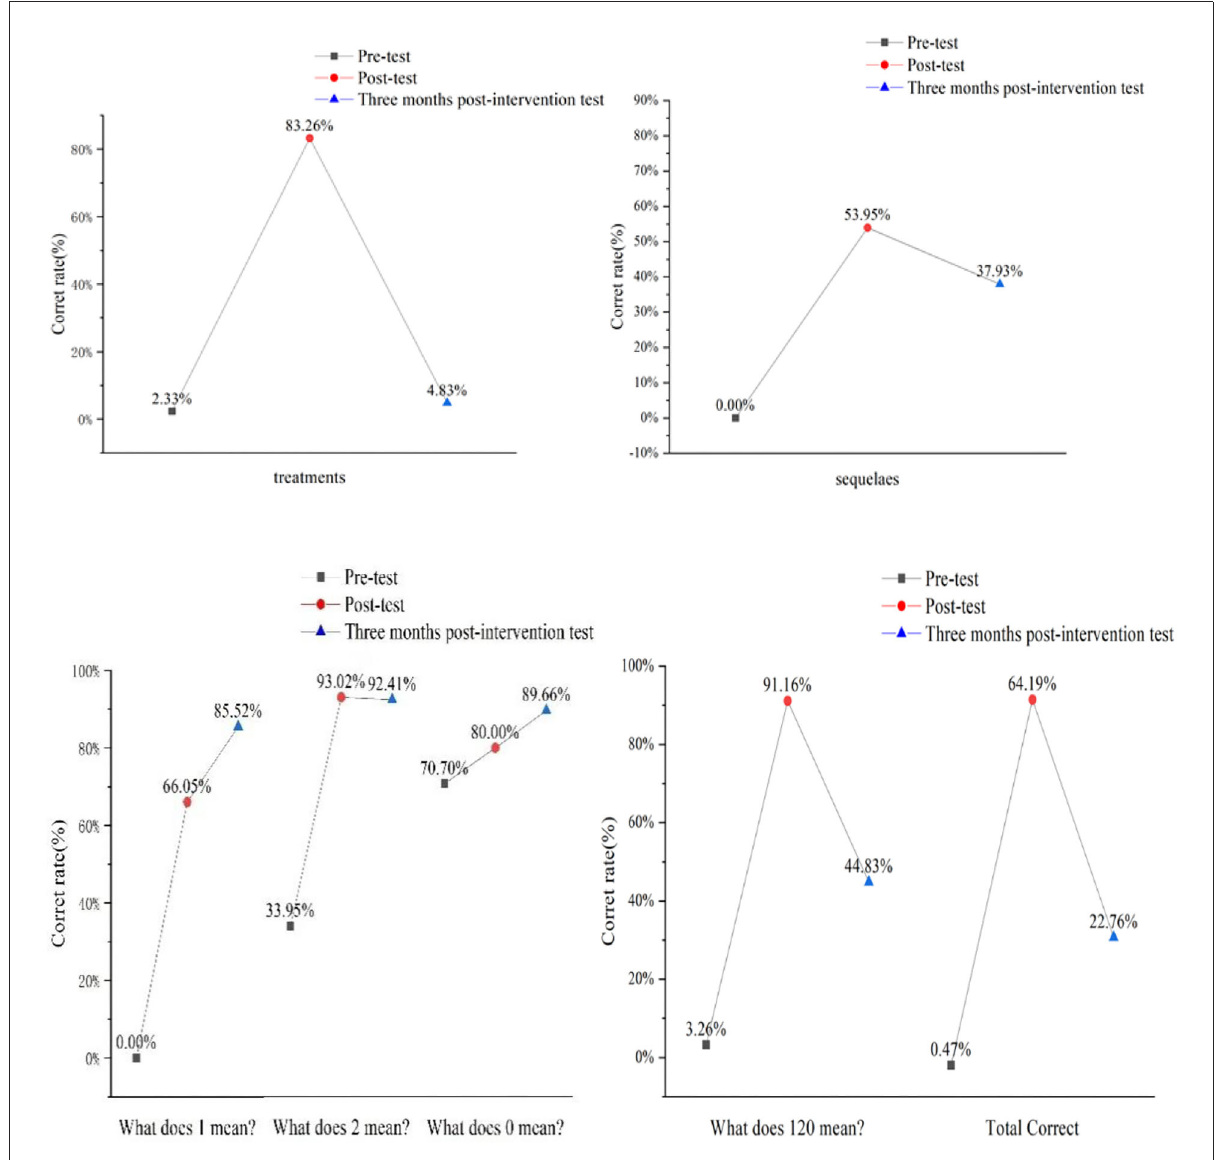
FIGURE2 Assessment of the stroke knowledge in pre-intervention, post-intervention, and follow-up surveys.